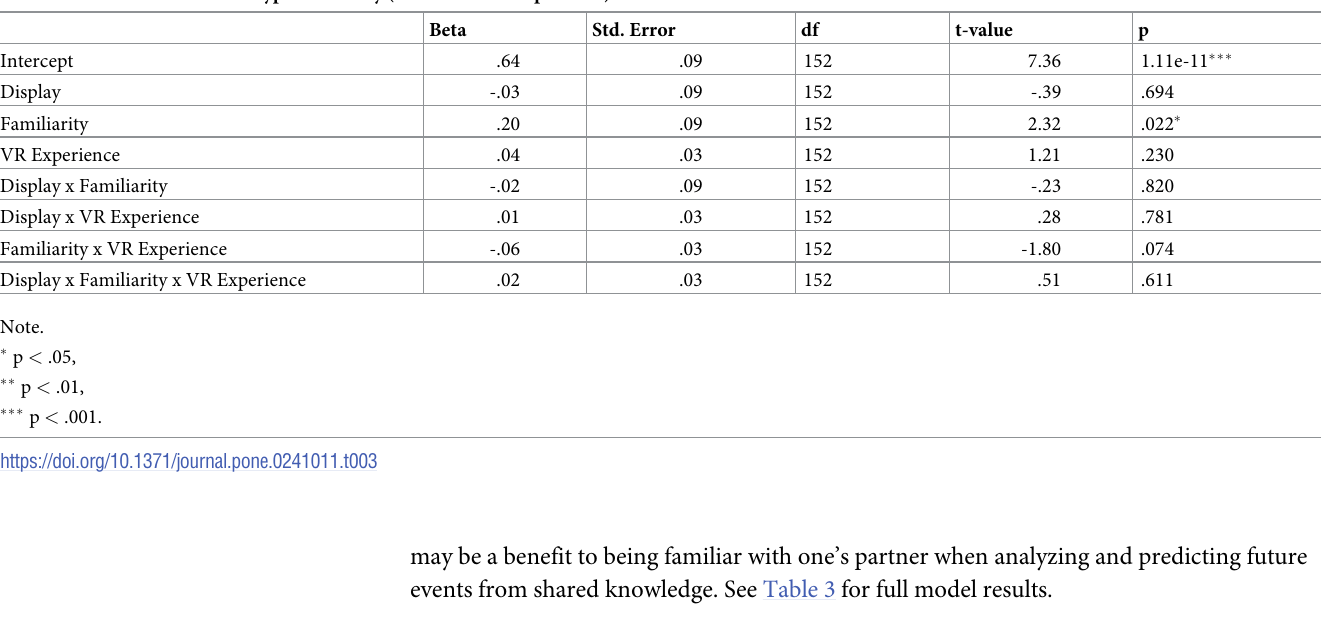
Table 3. Full model results for type 3 accuracy (centered at no experience).